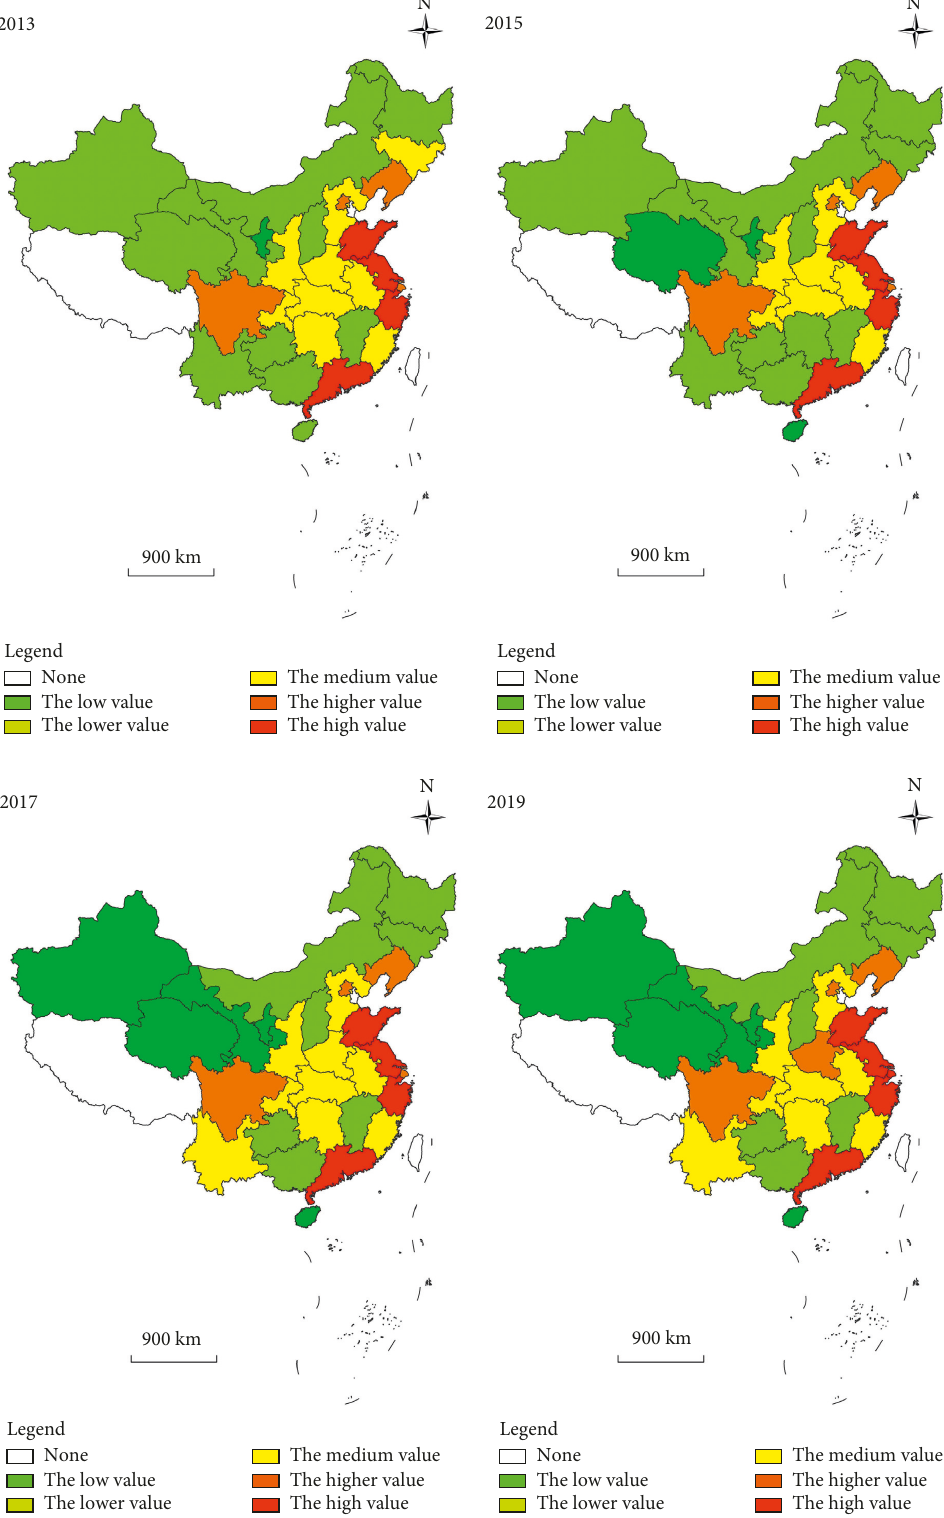
Figure 4: 2013–2019 provincial coupling and coordination